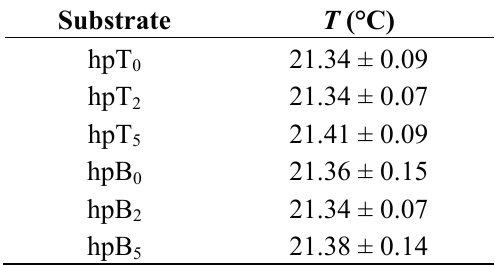
Table 4. Mean temperature of the single molecule